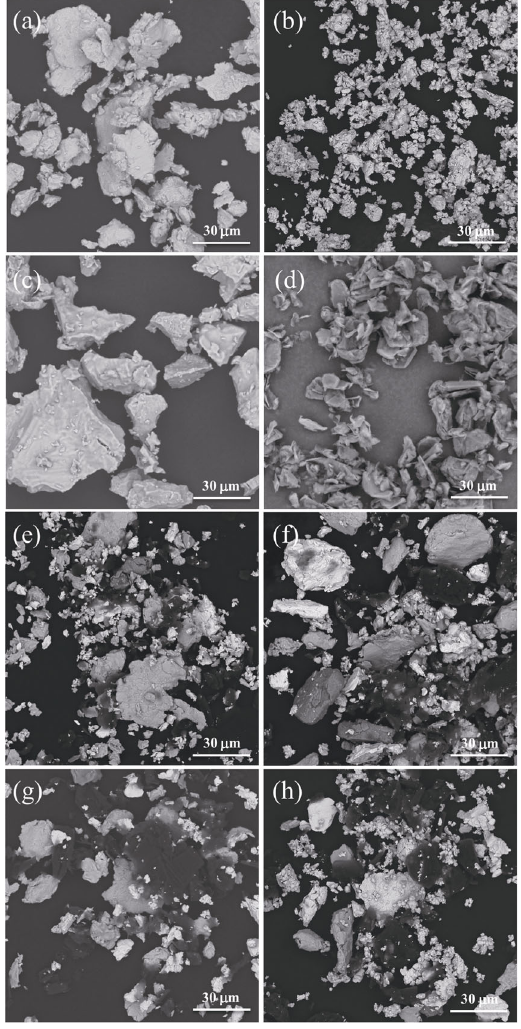
Fig. 1 Scanning electron microscopy (SEM) images of raw materials and samples after milling: (a) Zr, (b) Hf, (c) Ti, (d) carbon, (e) Zr 0.5 Hf 0.25 Ti 0.25 C 0.7 , (f) Zr 0.375 Hf 0.375 Ti 0.25 C 0.7 , (g) Zr 1/3 Hf 1/3 Ti 1/3 C 0.8 , and (h) Zr 0.3 Hf 0.5 Ti 0.2 C 0.8 .